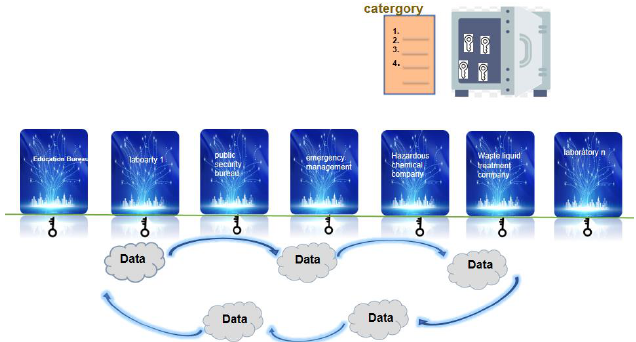
Figure 1. Proposed data ownership safety architecture to manage the laboratory.